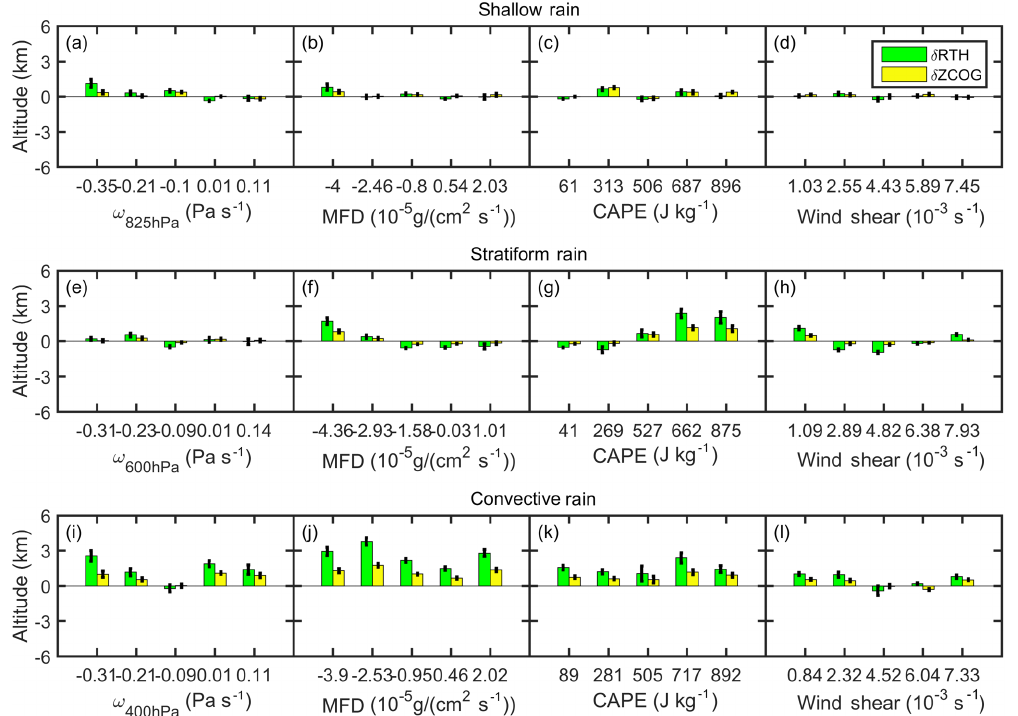
Figure 8. The differences of rain top height ( (cid:49) RTH) and ZCOG ( (cid:49) ZCOG) between polluted and clean conditions as a function of different meteorological conditions. (a) ω at 825hPa pressure level, (b) MFD, (c) CAPE, and (d) vertical wind shear for shallow regime; (e) ω at 600hPa pressure level, (f) MFD, (g) CAPE, and (h) vertical wind shear for the stratiform regime; (i) ω at 400hPa, (j) MFD, (k) CAPE, and (l) vertical wind shear for the convective regime. Data are from 2007–2012. Note that negative ω refers to upward motion. Red and blue colors represent polluted and clean cases, respectively. The vertical error bars represent 1 standard deviation. Each bin in a particular panel is equally spaced and labeled by its average